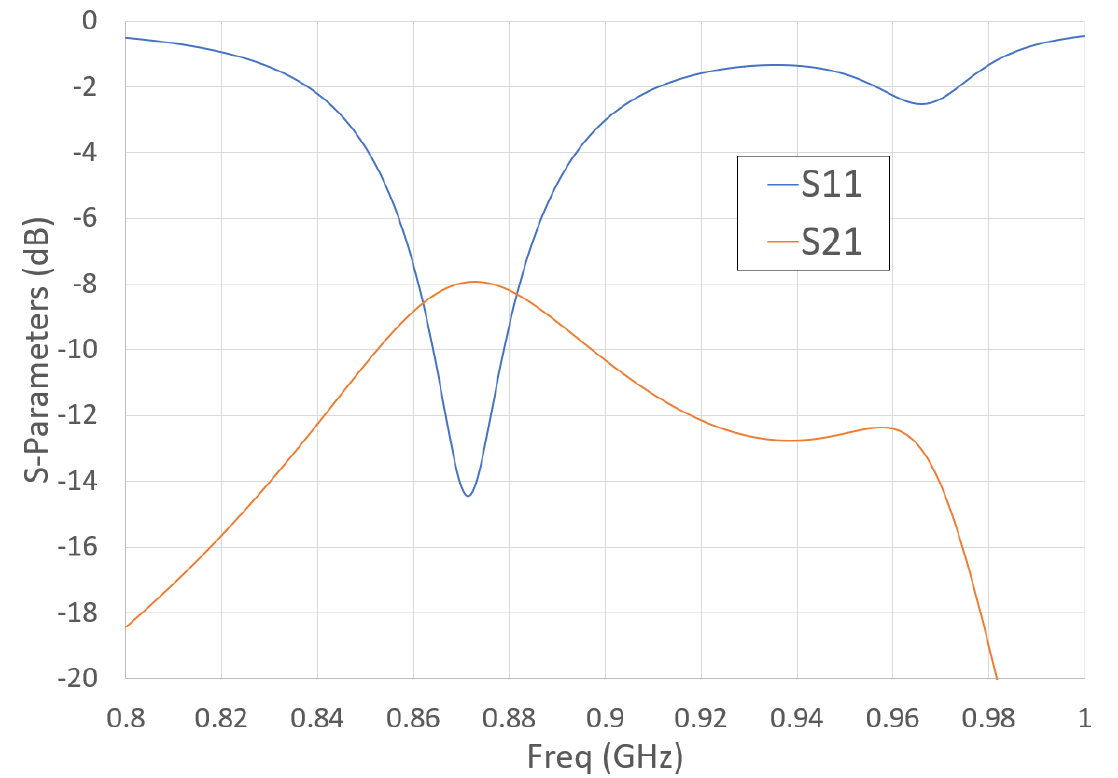
Figure 2. Simulated S-parameters of the proposed radiating